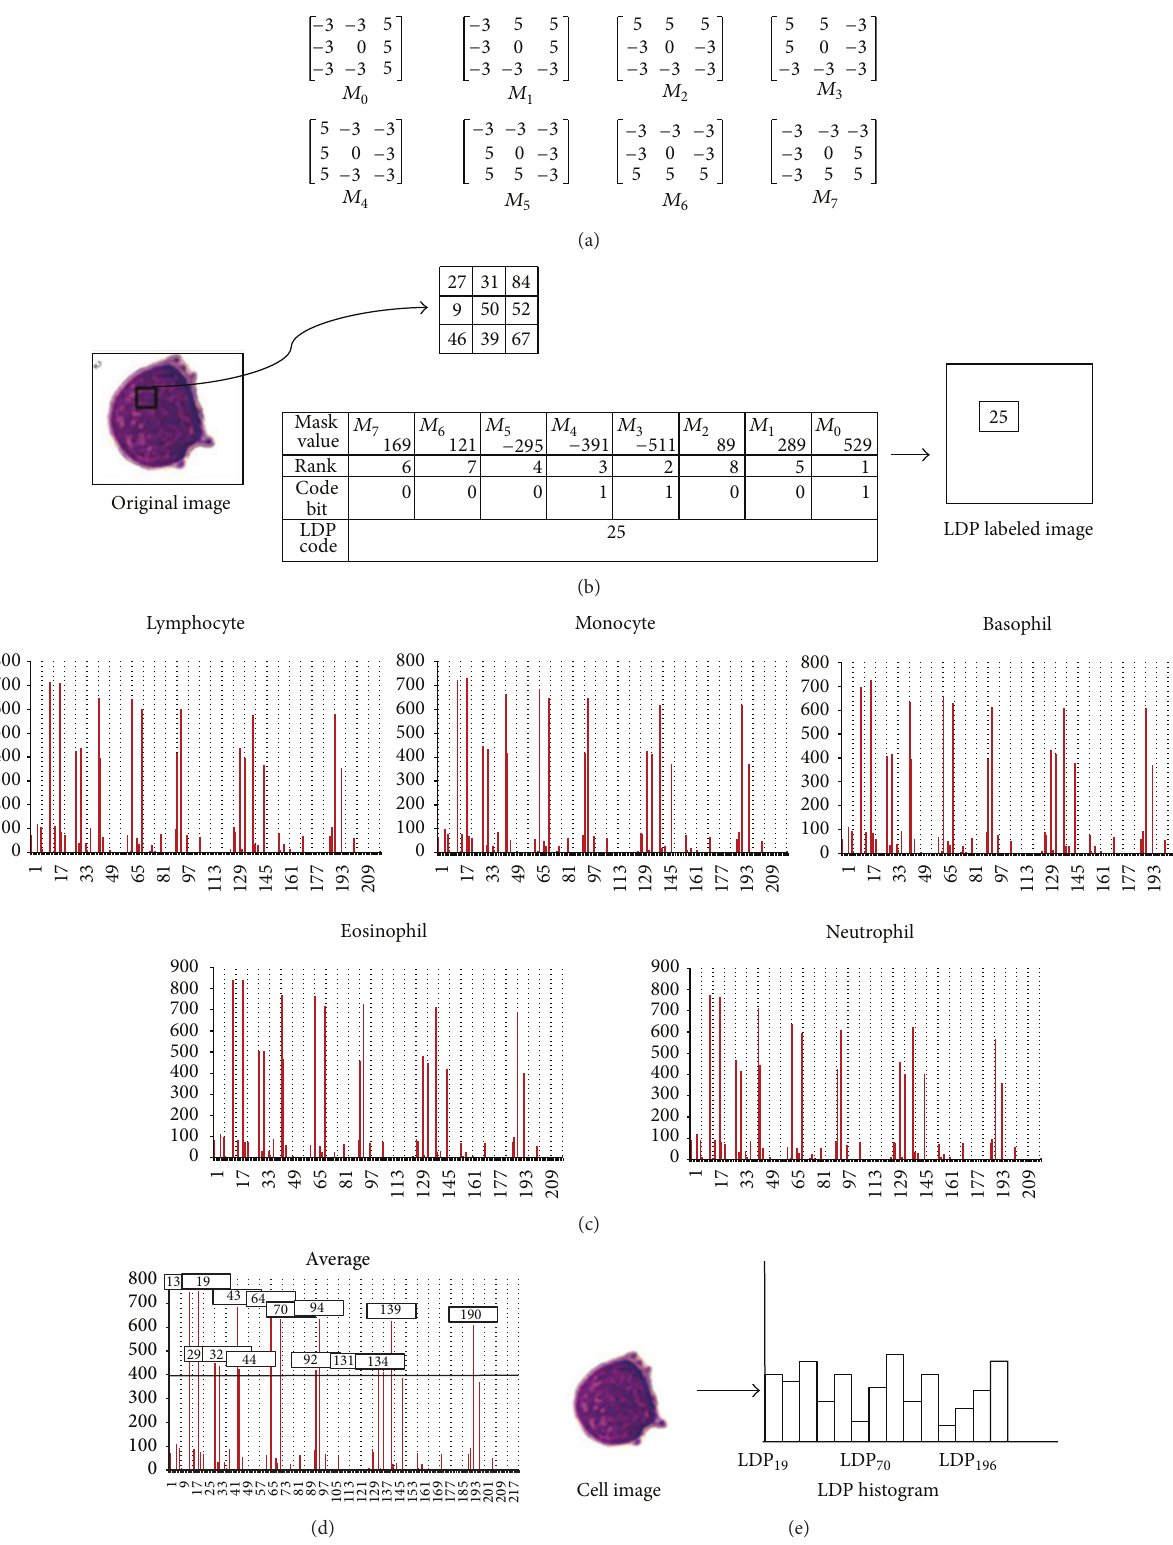
Figure 3: LDP-based features. (a) The Kirsch edge masks used for detecting the 8 directions. (b) The LDP code. (c) The LDP histograms with 218 bins. (d) The average LDP histogram. (e) The reduced LDP histogram with 14 bins for representing the cell